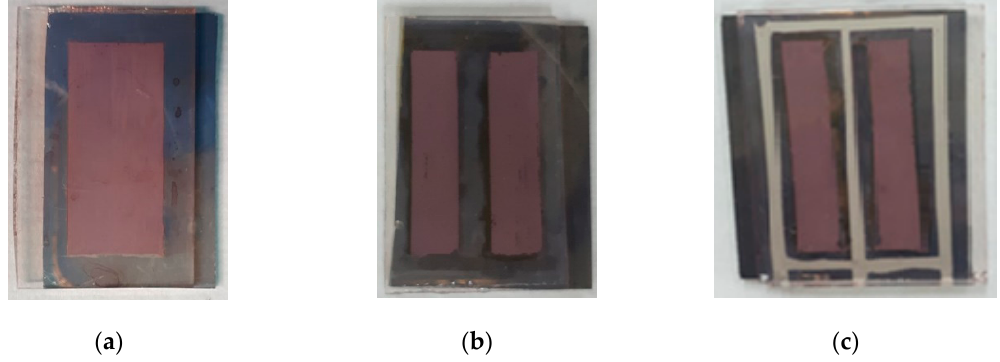
Figure 11. Photographs of DSSCs with ( a ) single, ( b ) two parallel, and ( c ) two parallel silver-grid connections.